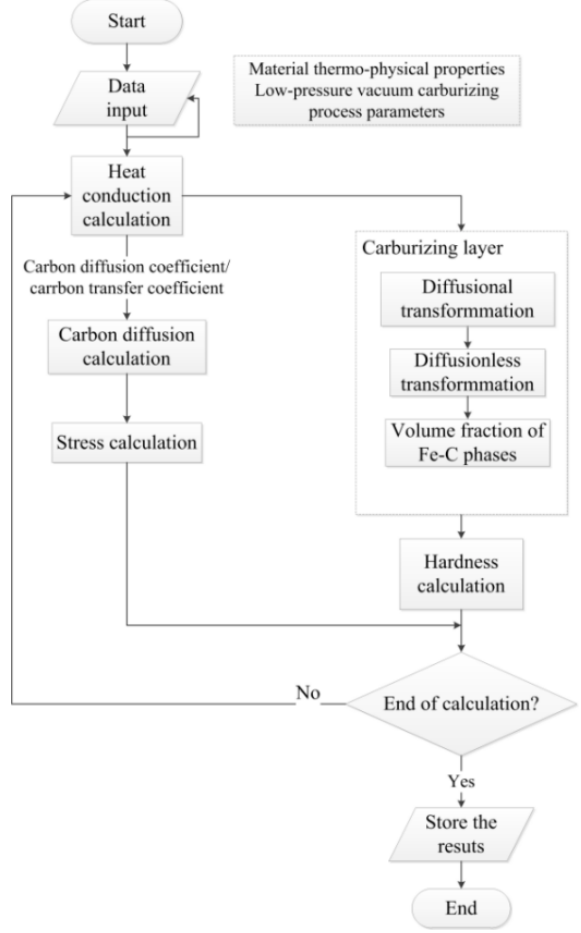
Figure 3. Flow chart of multi-field multi-scale model.